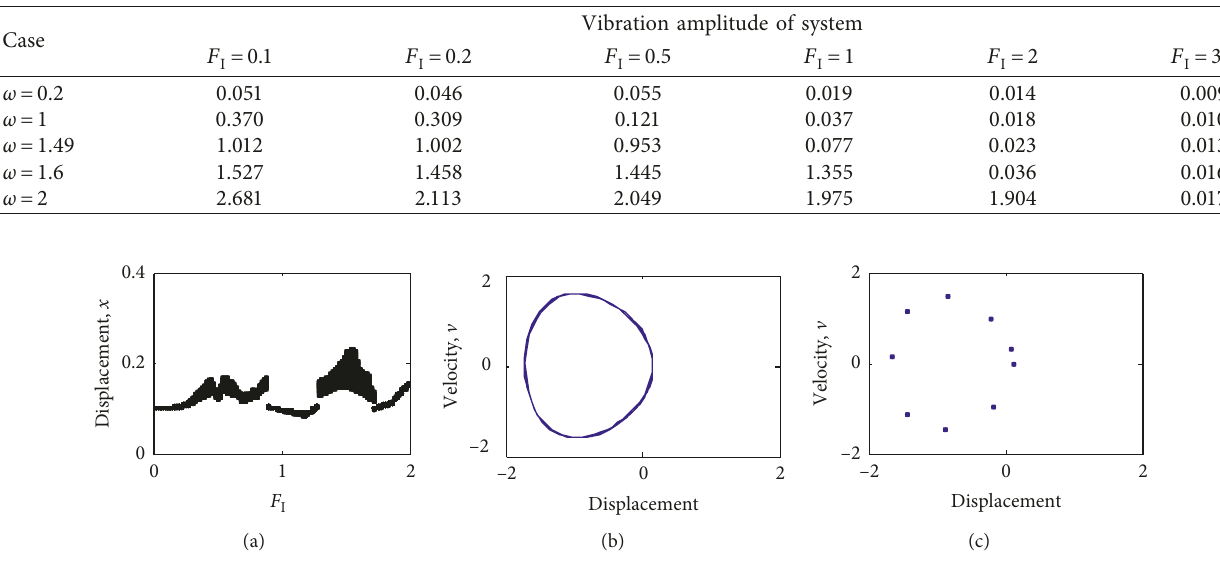
� 0.1, 0.2, 0.5, 1, 2, 3.5. I